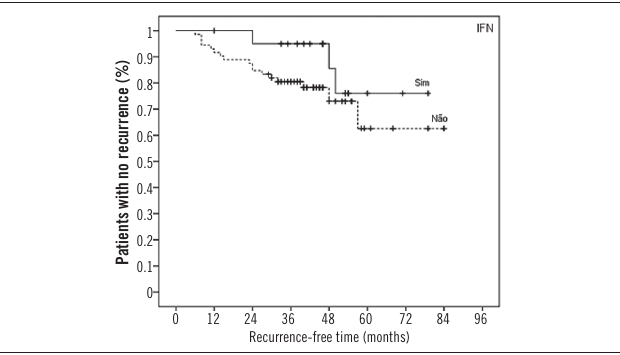
figure 4 – Kaplan-Meier curve relating the recurrence-free time and the percentage of patients without tumor